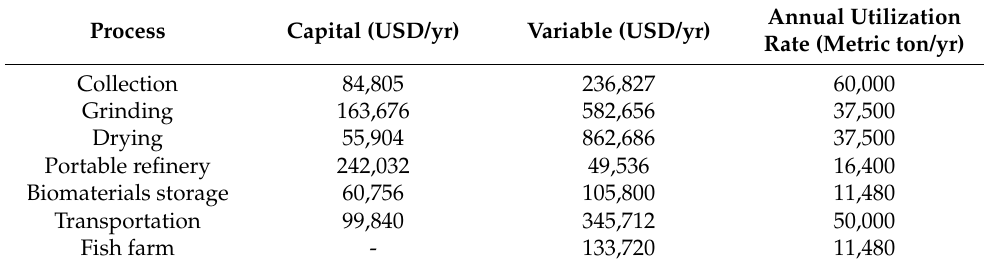
Table 5. Capital and operational costs, and annual utilization rate of each